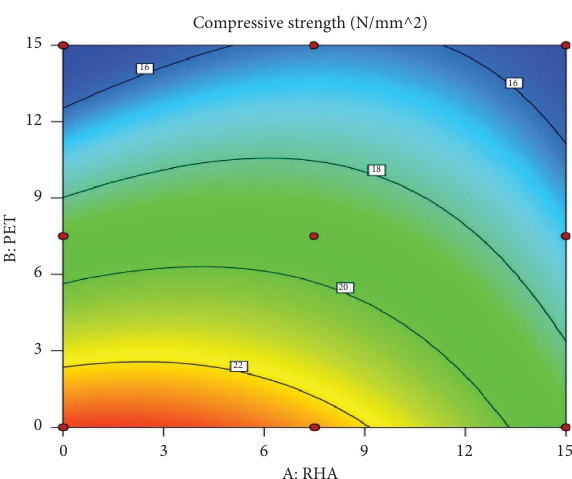
Figure 12: Response surface plot for compressive